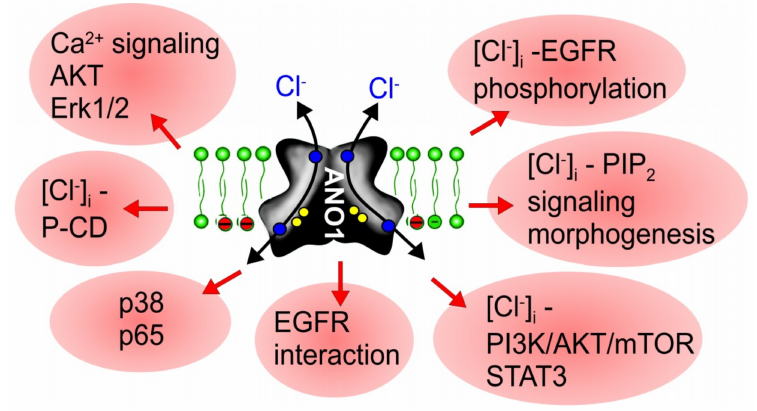
Figure 3. Mechanisms for ANO1-induced cell proliferation and cancer development. Scheme summarizing reported mechanisms for ANO1-induced cell proliferation and development of cancer. All pathways are inhibited by niclosamide and other inhibitors of anoctamins (Table 1). For further details and references, see main